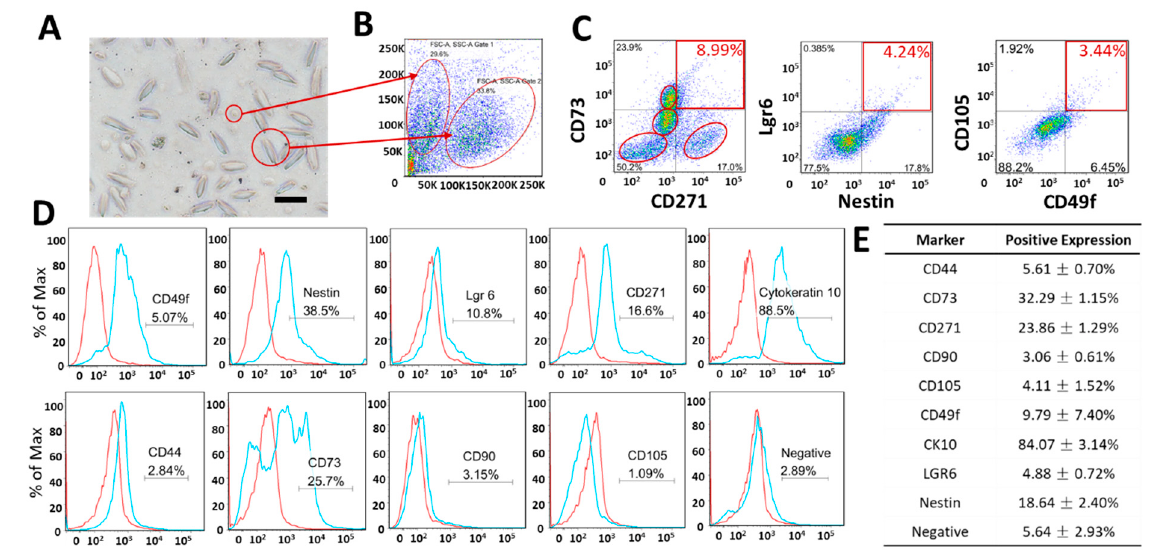
Figure 2. Morphological parameters and expression of CD73, CD271, Lgr6, nestin, CD105, CD49f, CD44, CD90, CK10 in a single cell suspension generated from the plucked hair follicle ORS. Control staining using isotype antibodies has been used to establish the gates for analysis. The compensation of the double fluorescence staining was <1%. ( A ) Heterogeneous cells were obtained in a single cell suspension by the means of trypsinization, and two major morphologically distinct cell populations were microscopically observed—smaller and larger cells. ( B ) Plot graph of forward and side scatter-based distribution (FSC and SSC) identified two major morphologically distinct ORS cell populations. ( C ) Fluorescence-based double-stained plots of ORS cells as representatives of stem cell populations. Double-stained cells were highlighted (red boxes). Four subgroups of cells were found in the plot of CD271/CD73 staining (red circles). ( D ) Single staining of CD49f, nestin, Lgr6, CD271, CK10, CD44, CD73, CD90, CD105, and negative MSC markers in the ORS population. Negative markers comprised a combination of the supplied negative MSC cocktail (PE CD45, PE CD34, PE CD11b, PE CD19, and PE HLA-DR). Blue histograms represent the antibody staining and the red ones represent isotype staining. ( E ) The portions of the ORS cells expressing a single marker are presented as an average percentual value ±SD. Magnification ( A ) 20×, scale bar 100 μ m.